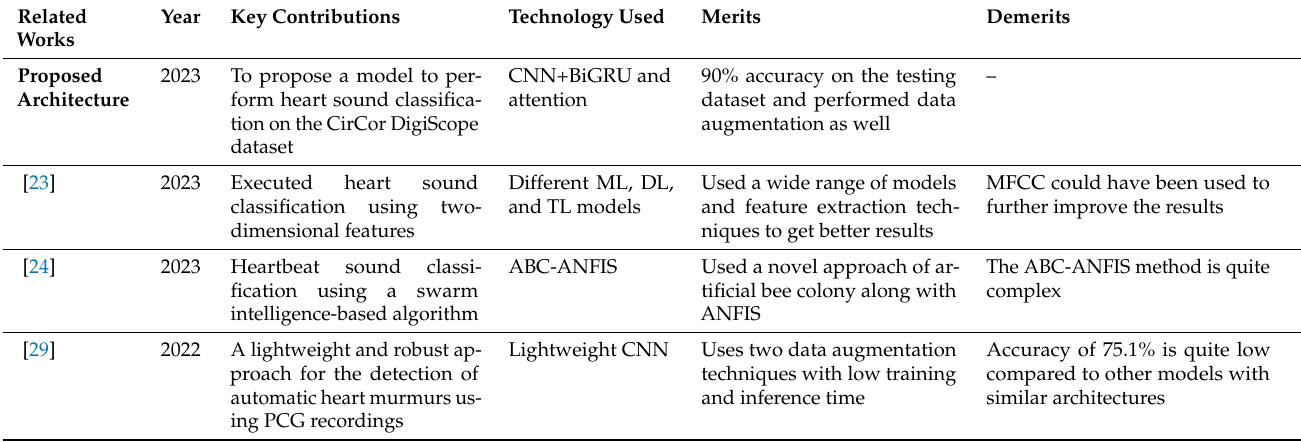
Table 1. Comparative analysis of state-of-the-art approaches on heartbeat sound